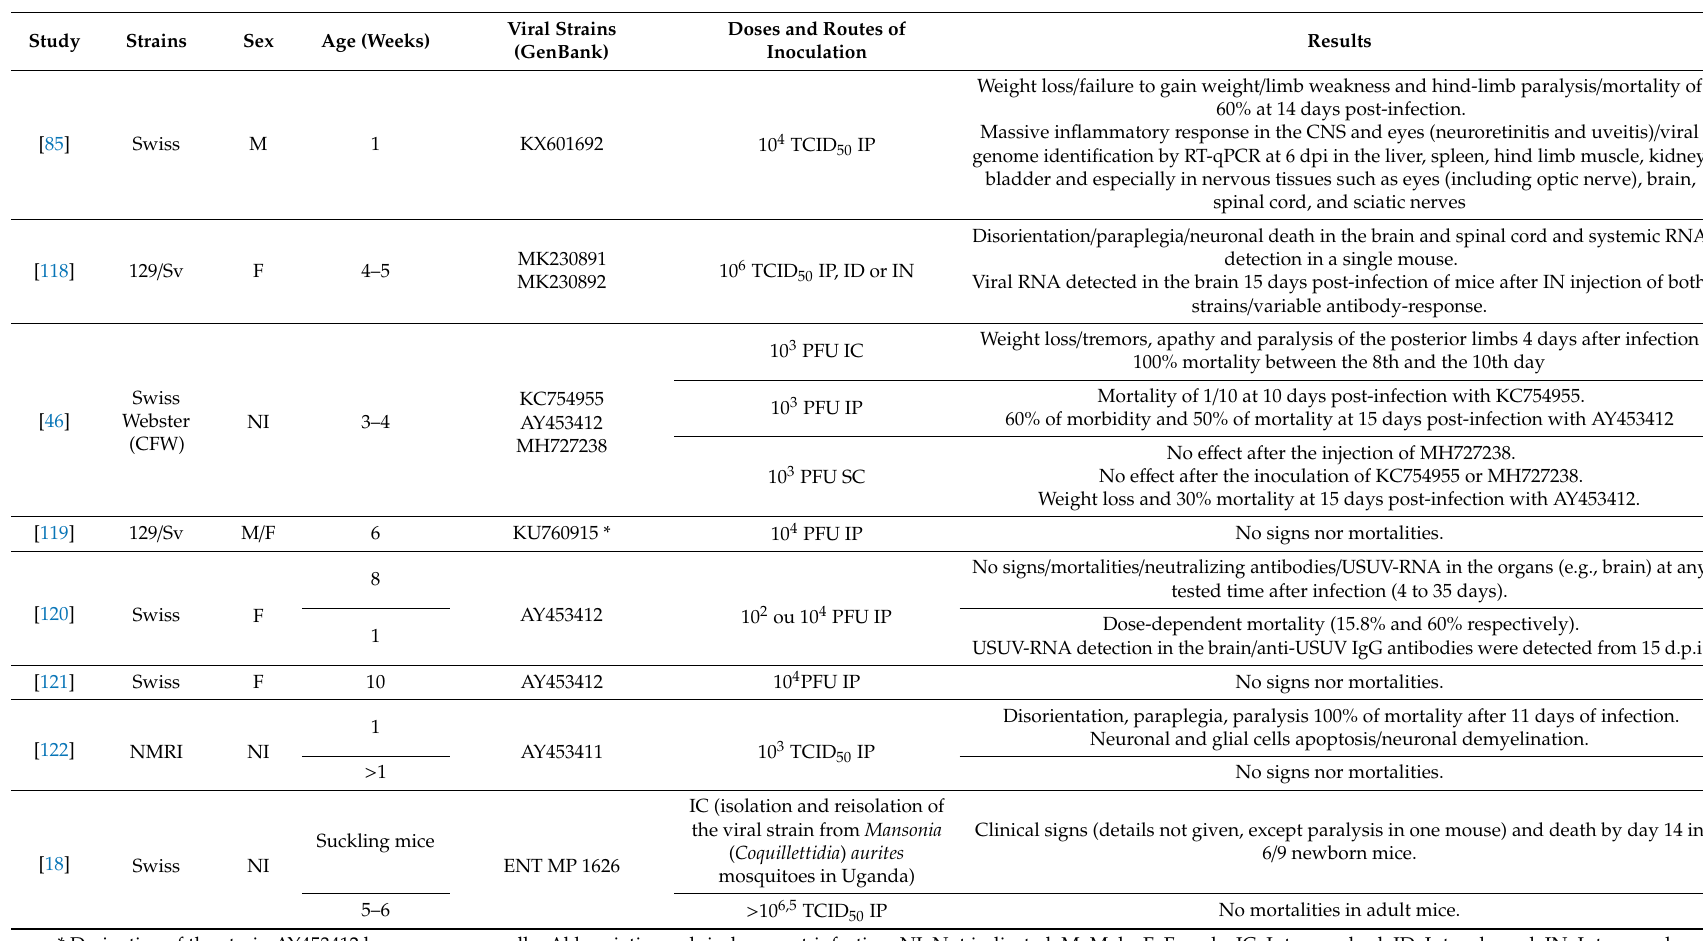
Table 5. Immunocompetent mouse models for studying USUV biology.